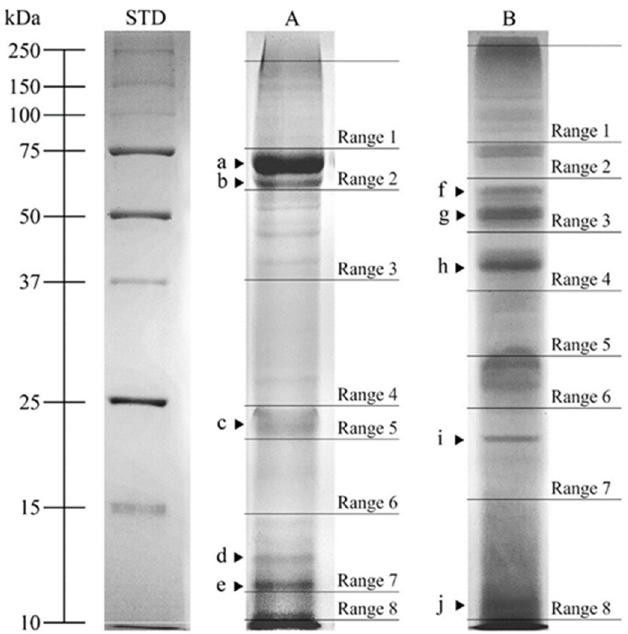
Figure 4. One-dimensional SDS-PAGE (12%). Line A: sperm intracellular proteins (SIPs) of dog ( Canis lupus familiaris ) cauda epididymal spermatozoa (n = 15); Line B: sperm membrane-associated proteins (SMAPs) of the dog cauda epididymal spermatozoa. Proteins were identified using mass spectrometry in ranges 1–8 (Range 1 to 8) for SIPs and SMAPs. Differentially abundant protein fractions were marked with letters from a to j. STD—molecular weight markers. Table 1. Average optical density (OD) values (mean ± SE) of differentially abundant proteins (DAPs) of the sperm intracellular proteins (SIPs) and the sperm membrane-associated proteins (SMAPs) of dog ( Canis lupus familiaris ) cauda epididymal spermatozoa (n = 15). Different superscripts within rows indicate statistically significant differences ( p ≤ 0.001) between fractions. DAPs were marked with letters from a to j. MW—average molecular weight.